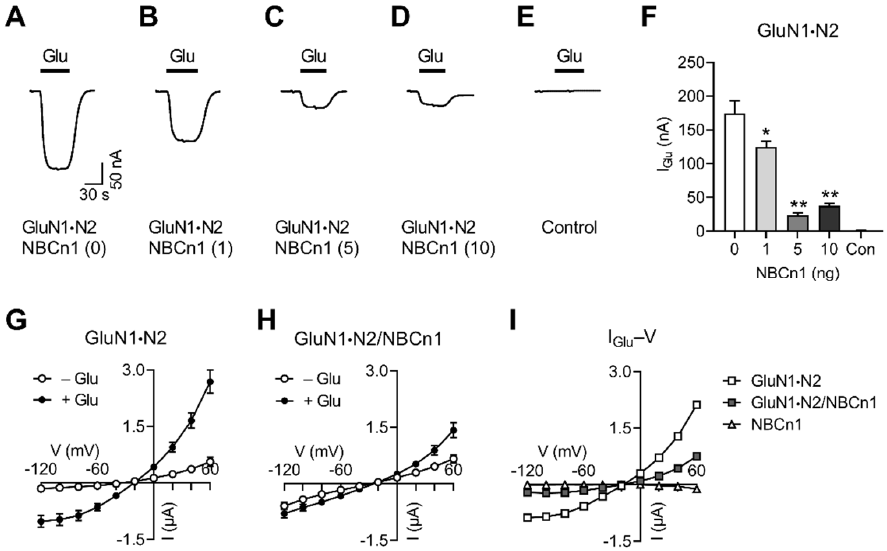
Figure 2. NBCn1 channel activity decreases I Glu produced by GluN1·N2. ( A ) Representative I Glu produced by GluN1·N2. I Glu was measured with an application of 100 µM glutamate (10 µM glycine, no Mg 2+ ). Recording was performed in CO 2 /HCO 3 − -free ND96 solution containing 96 mM NaCl (holding potential of –40 mV). ( B – D ) Representative I Glu produced by GluN1·N2/NBCn1. A fixed amount of GluN1·N2 was coexpressed with 1, 5, or 10 ng of NBCn1. ( E ) Control. ( F ) Mean I Glu . Data were obtained from 4–5 oocytes/group. * p < 0.05, ** p < 0.01 compared to GluN1·N2 alone, one-way ANOVA with Dunnett post-test. ( G ) and ( H ) I–V relationships of glutamate-evoked responses by GluN1·N2 ( n = 6; ( G )) and GluN1·N2/NBCn1 ( n = 5; ( H )). ( I ) I Glu –V relationships. I Glu is the mean difference before and after glutamate application in ( G ) and ( H ). NBCn1 alone served as a control ( n = 4).